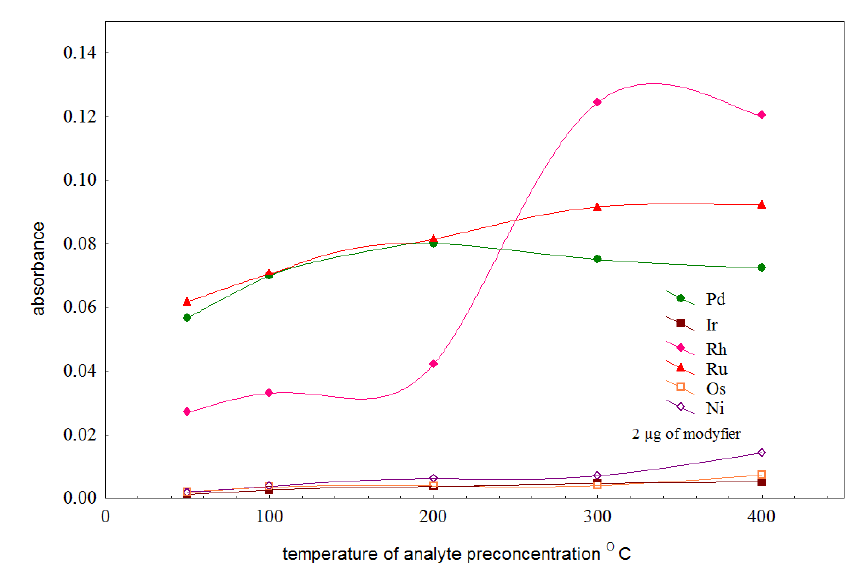
Fig. 1 The temperature dependence of the analytical signal corresponding to arsenic (1